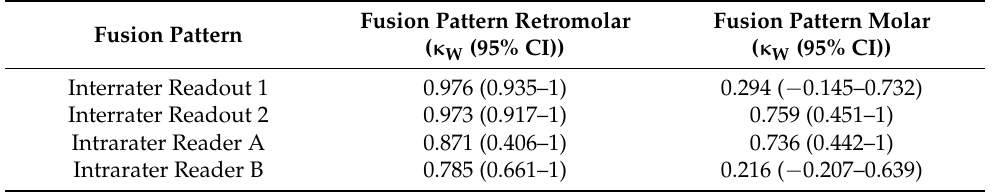
Table 3. The interrater and intrarater agreement regarding the fusion pattern analysis in the retromo- lar and molar region is expressed with the following kappa